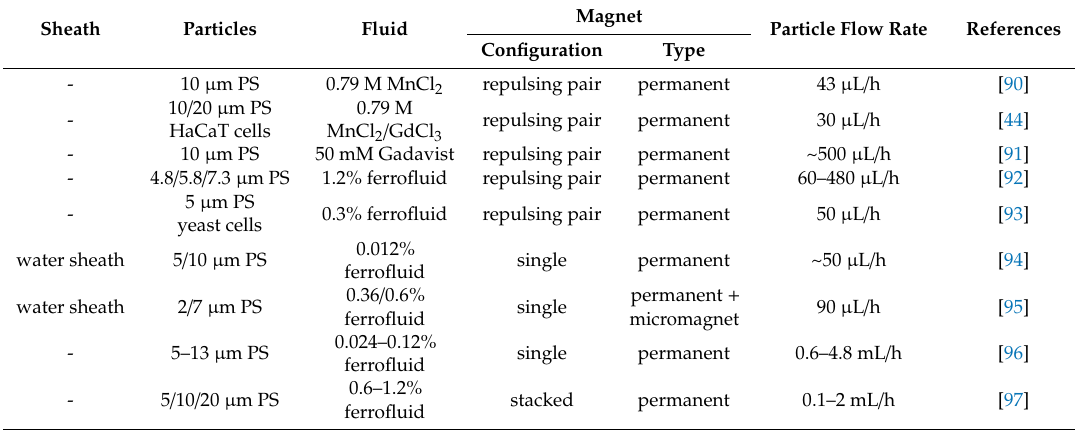
Table 2. Summary of the published papers on diamagnetic particle focusing in magnetic fluid